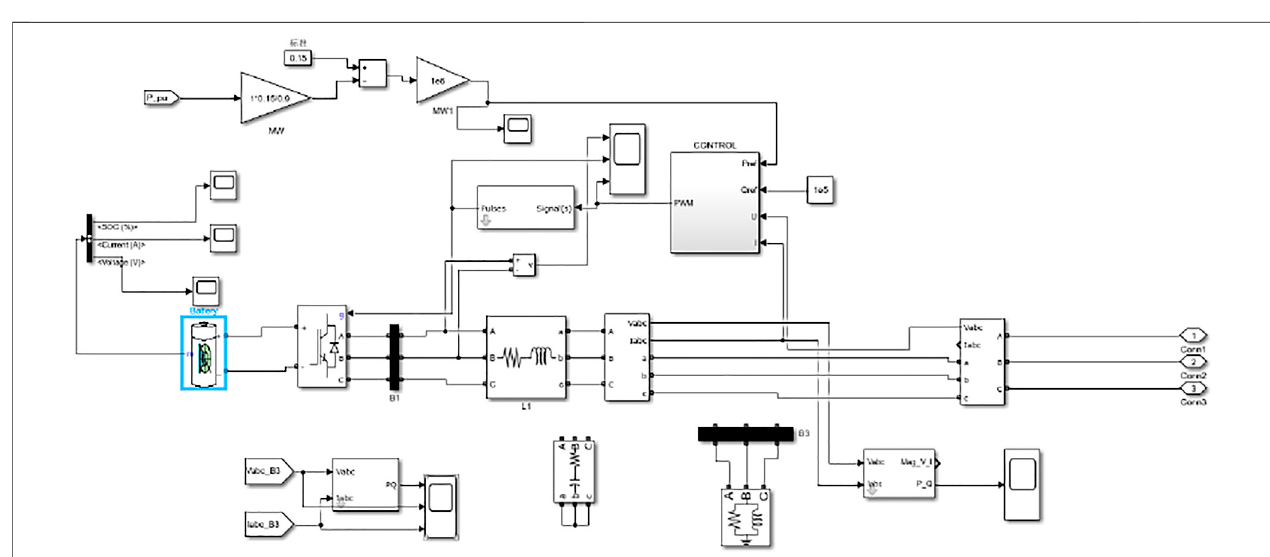
FIGURE 13 | Internal structure diagram of the energy storage system